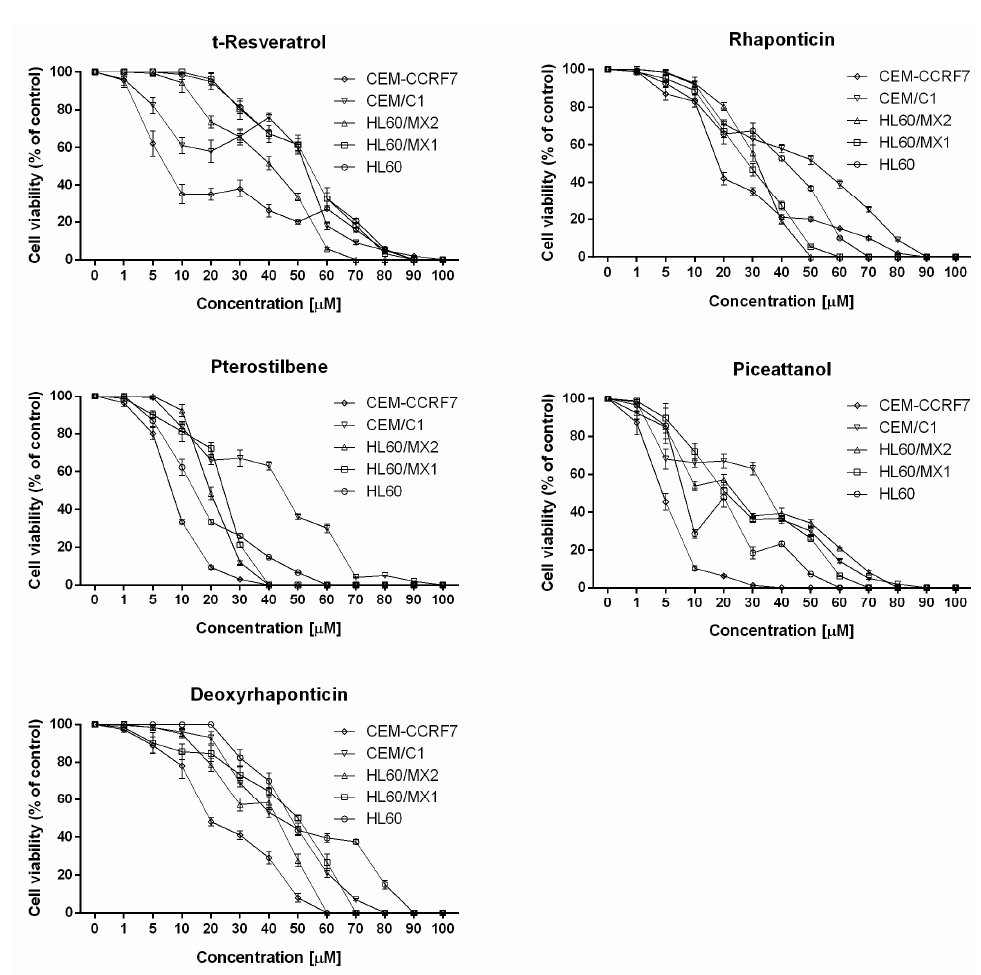
Figure 2. Cell viability analysis of tested stilbene derivatives from conventional trypan blue assay. Each value is shown as mean with standard deviation (SD).